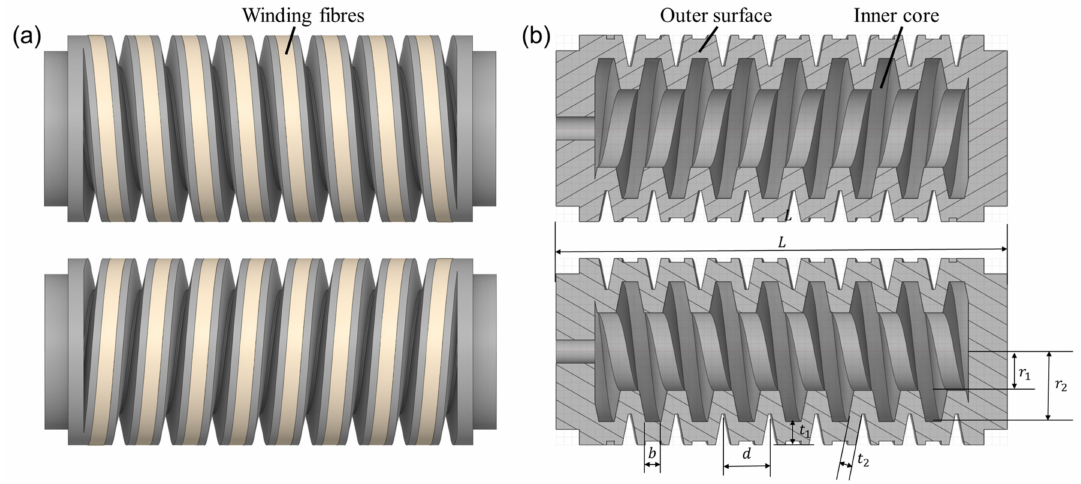
Figure 1. Pneumatic soft helical actuators: ( a ) two opposite helical structures; ( b ) longitudinal sections and the geometric parameters.